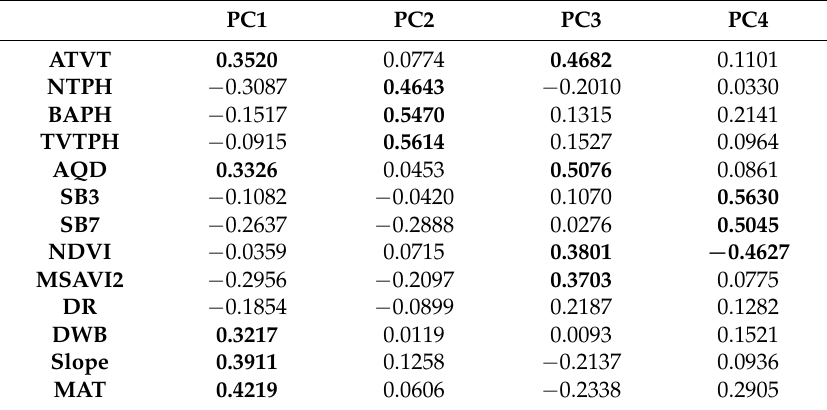
Table 3. Eigenvectors of the correlation matrix.